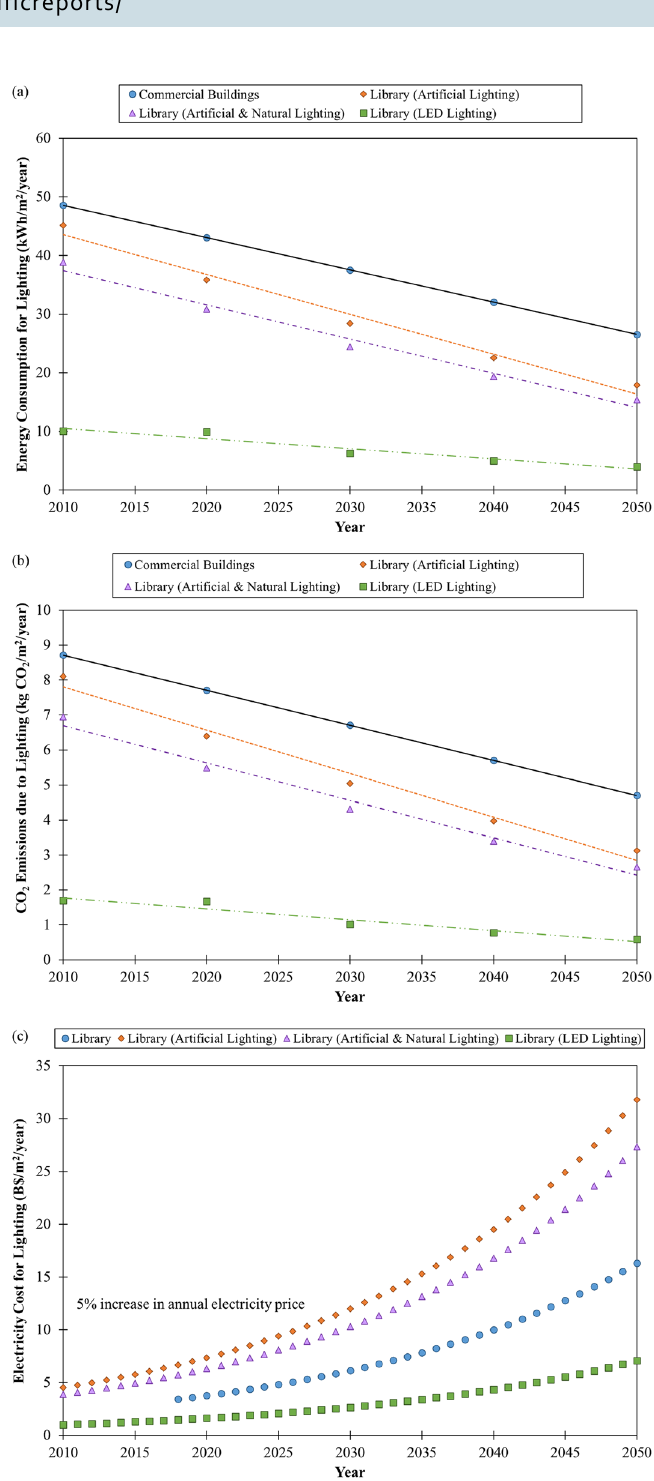
Figure 6. (a) Estimated energy consumption, (b) decarbonisation pathway and (c) projected electricity costs (with a 5% increase in annual electricity price) of different lighting systems for a library building in Brunei Darussalam in comparison to commercial buildings in Southeast